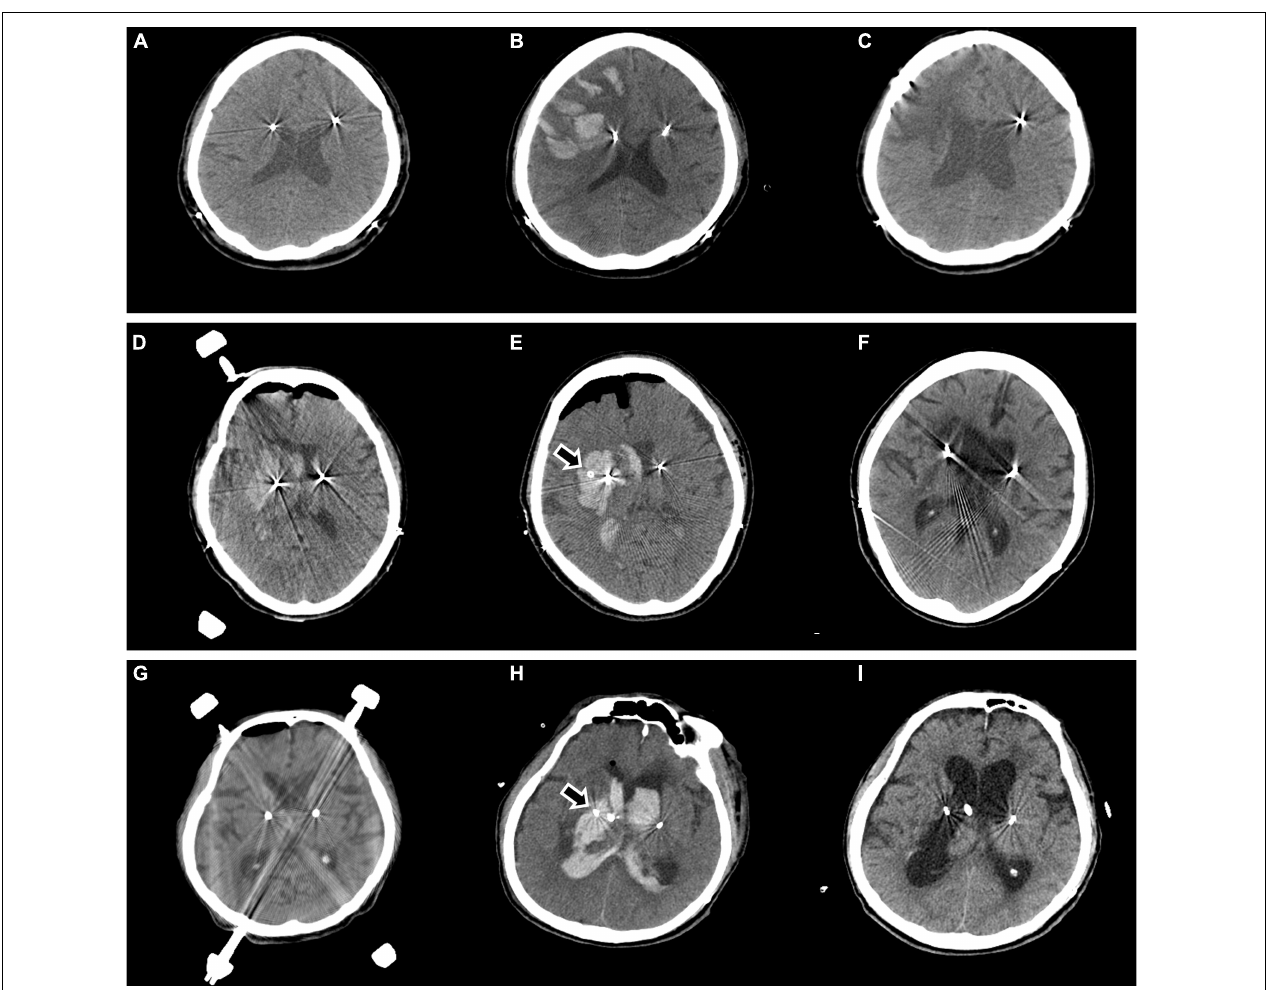
FIGURE 4 | Major ICH requiring surgical treatment is observed in three cases. In one patient, no abnormalities are observed on brain CT immediately after surgery (A) , but ICH developed in the right frontal lobe with seizures 8 h after surgery (B) . The patient underwent craniotomy and hematoma evacuation due to a large ICH, increased edema, and a midline shift. Two months later, the patient was transferred for rehabilitation (C) . In another patient, right thalamic ICH and IVH are observed on brain CT after intracranial electrode insertion (D) , and hematoma catheter insertion was performed immediately ( E arrow). After 1 month, the ICH was resolved, and the patient was transferred for rehabilitation (F) . In another patient, no abnormalities are observed on brain CT immediately after surgery (G) , but right thalamic ICH and IVH are observed on brain CT 16 h after the surgery, and hematoma catheter insertion was performed ( H arrow). The hematoma is resolved (I) , but the patient died from aspiration pneumonia on postoperative day 30. ICH, intracerebral hemorrhage; CT, computed tomography; IVH, intraventricular